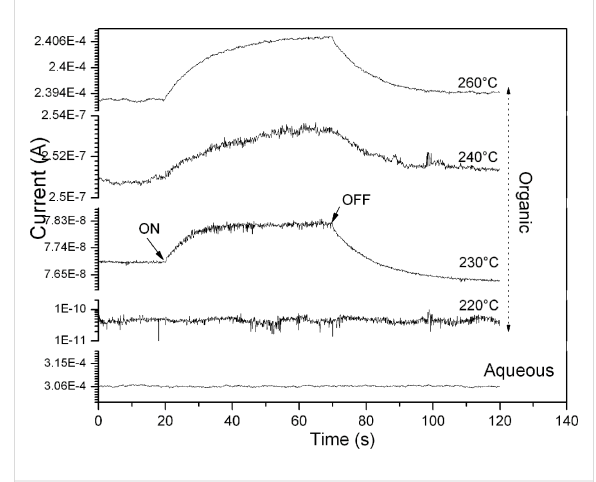
Figure 7: Photoconductivity of copper sulfide films, synthesized in both aqueous and organic media. Only the organic samples show photo-